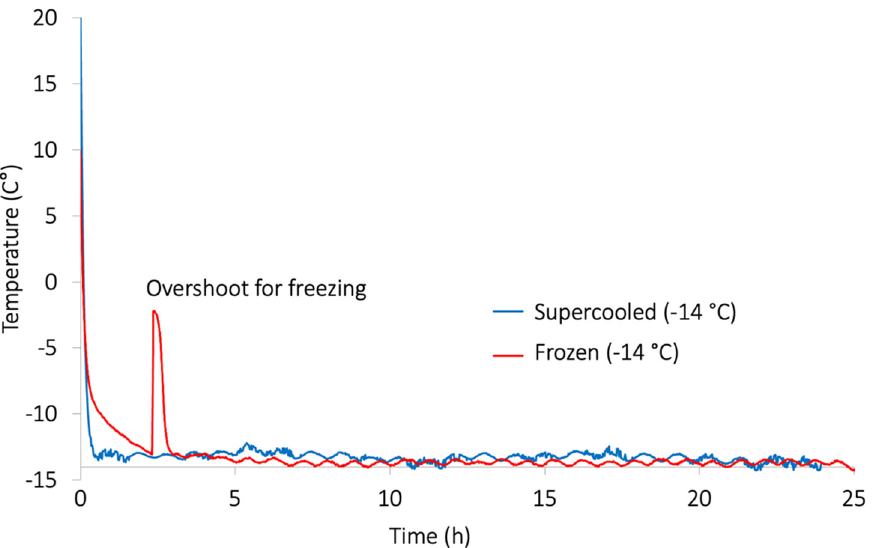
Figure 3. Temperature profiles of supercooled and control vaccines. The control vaccine sample (without OMF treatment) was frozen after 2.5 h of storage as indicated by the temperature overshoot. In general, as the temperature of the sample is lowered below its freezing point, ice nucleation occurs. This phase change causes the release of latent heat with the freezing point being revealed. Once all latent heat has been released, the temperature of the sample continues to decline until it matches the temperature of its ambient surroundings.